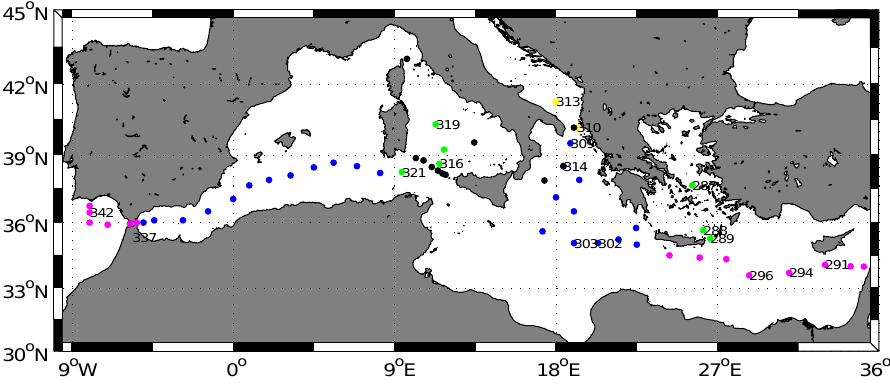
Fig. 1. Map of the Mediterranean Sea with the stations from the Meteor M84/3 (colour dots) and Urania EF11 (black dots) cruises where CO 2 measurements were taken. The colour code for the M84/3 stations corresponds to the data showed in Figs. 12–14. scales. This fact mostly mentioned for general circulation studies can also be applied for biogeochemical studies, eu- trophication, hypoxia, acidification,